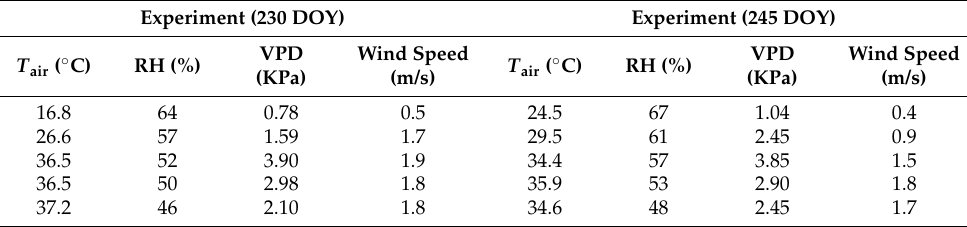
Table 6. Mean values of the weather parameters that were registered on the sampling days. Experiment (230 DOY) Experiment (245